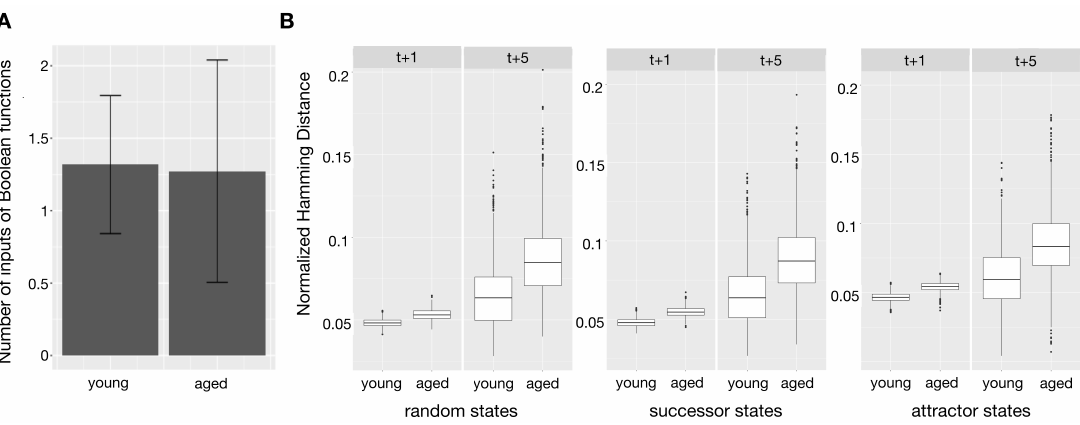
Figure 3. ( A ) shows the mean of the number of inputs of all Boolean functions of the young and aged phenotype Boolean networks as a bar plot. The standard deviations are included as error bars. ( B ) The boxplot shows the average, normalized Hamming distance between the successor